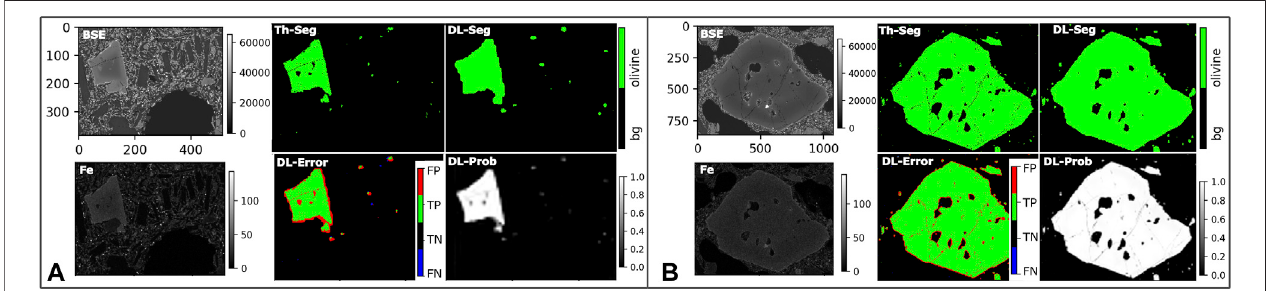
FIGURE 4 | Result of the deep learning segmentation. The BSE image is used as input for the semantic segmentation model. For every pixel in the BSE image it is knownwhetheritisolivineornon-olivine(Th-Seg)fromtothecorrespondingEDSmapsderivedfromthresholdsegmentation(e.g., Table2 ).Thesemanticsegmentation producedbyDL(DL-Seg)slightlyoverestimatesolivinepixels,mostlyatcrystalrims(redlineinDL-Error).DL-Probshowsprobabilitiesbetween0and1ofbeinganolivine pixelpredictedbythenetwork.Thethreshold dl th isappliedtoDL-ProbtoretrieveDL-Seg. FP-, TP-,TN-and FN-arefalsepositive,true positive,true negative and false negative pixels respectively. The panels (A) and (B) show the result for the crystals III and IV (cf. Figure 1 ) respectively. The BSE and Fe in the A panel show olivine with almost nested clinopyroxene at the lower end.